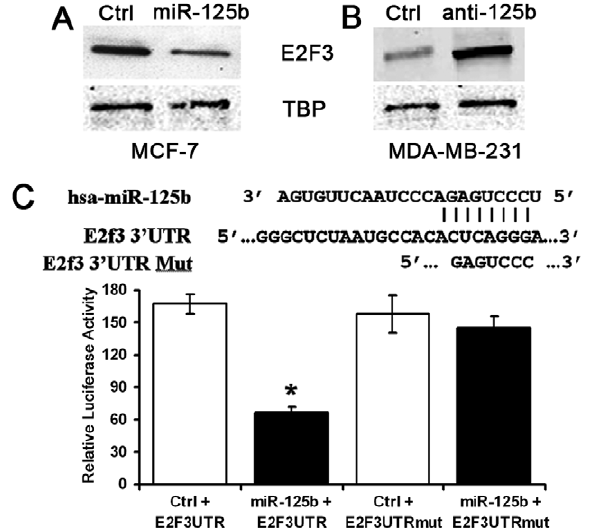
Figure 6. E2F3 was a direct target of miR-125b in breast cancer cells. (A) MCF-7 cells were transfected with 100 nM pre-miR-125b or pre-scramble control (Ctrl). (B) MDA-MB-231 cells were transfected with 100 nM anti-miR-125b or anti-scramble control (Ctrl). Twenty-four hours after transfection, nuclear lysates were prepared for Western blotting with an antibody against E2F3, and TBP was used as a loading control. (C) MCF-7 cells were co-transfected with luciferase reporter plasmids with intact or mutant 3 9 UTR of E2F3, pre-miR-125 or pre-scramble control (Ctrl). Luciferase activity was measured at 48 h post-transfection using a dual luciferase reporter assay. The results were expressed as relative luciferase activity (firefly/renilla luciferase). Data represented mean 6 SD of triplicate experiments. * p =0.002.